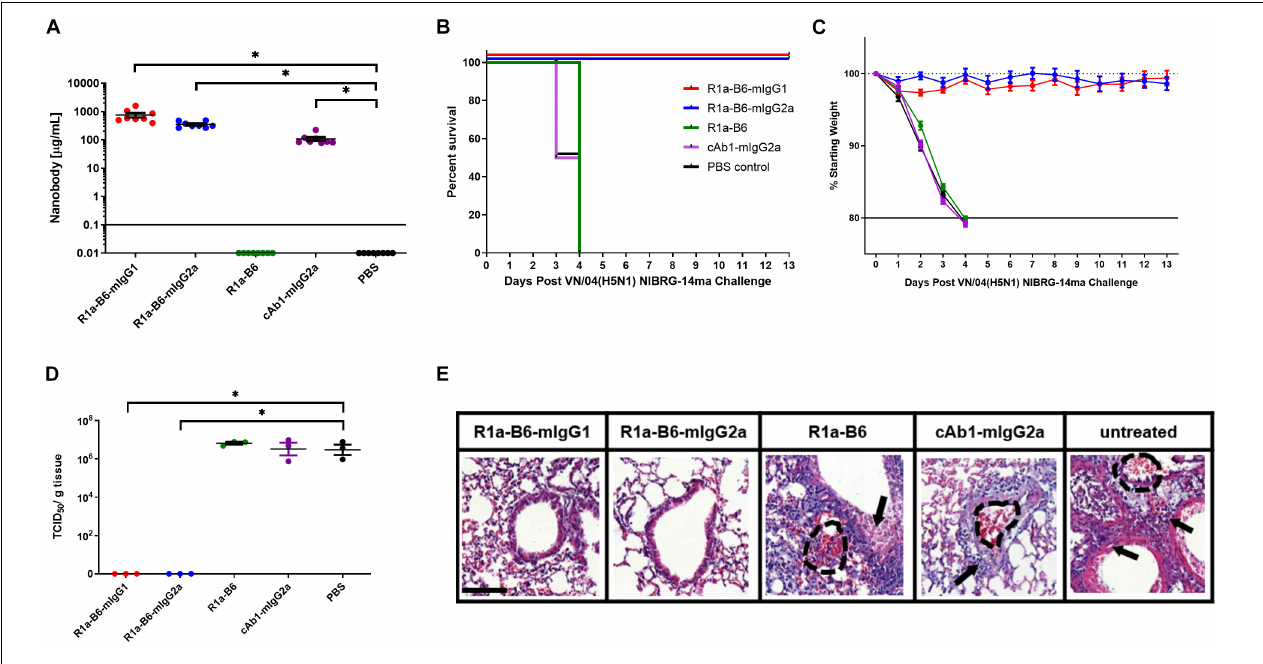
FIGURE 5 | Prophylactic efficacy of AAV expressed nanobodies in a mouse challenge model of VN/04 (H5N1) NIBRG-14ma. (A) Total nanobody-Fc in serum was measured by ELISA in samples taken 39 days after IM injection of AAV vectors pre-challenge with VN/04(H5N1). Comparisons are shown in brackets ( *p < 0.05). Mice were then infected intranasally with 10 MLD 50 (mouse lethal dose) of A/Vietnam/1194/2004 (H5N1) NIBRG-14ma 42 days post-AAV IM injection. Survival (B) and weight loss (C) were monitored for 13 days. (D) Residual viral load was determined as indicated by TCID 50 /g of tissue from lung homogenates 3 days post-challenge with 10 MLD 50 VN/04. Each dot represents an individual mouse. Comparisons are shown in brackets ( p < 0.05). (E) Representative histological lung sections from mice that received AAV encoding R1a-B6-mIgG1, R1a-B6-mIgG2a, R1a-B6, cAb1-mIgG2a, and PBS (untreated) 3 days post-infection with VN/04 NIBRG-14ma. Lungs were harvested from mice and stained with Hematoxylin and Eosin (H&E). Arrows represent thickening of the alveolar walls and lung ruptures are represented by dashed lines. Scale bar = 100 µ